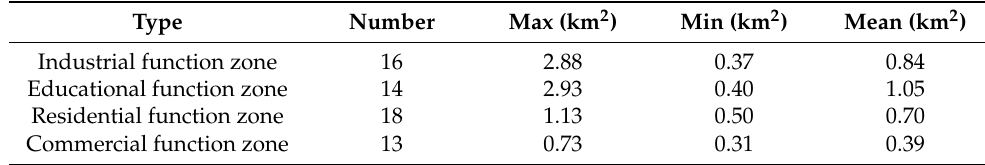
Table 4. Statistical features of the function zones.